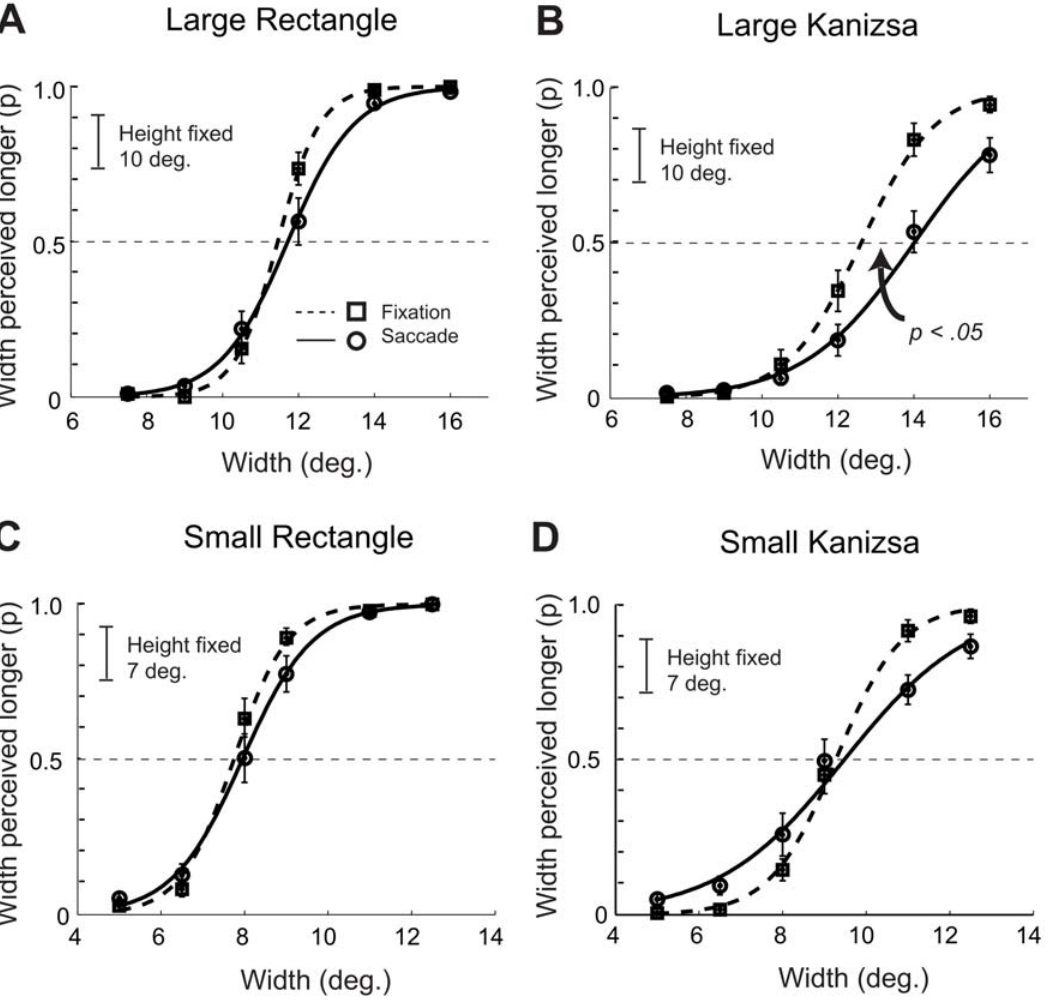
Figure 3. Experiment 1A: Proportion of participants reporting the width was longer than the fixed height. Vertical bars indicate SEMs.